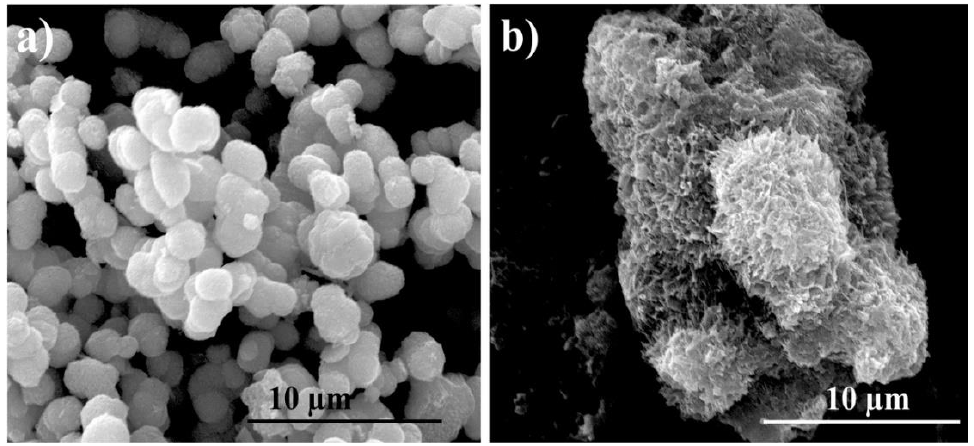
Figure 4. SEM images of the ( a ) TiO 2 _SL1 and ( b ) TiO 2 _SL2 structures proposed for a scattering effect.